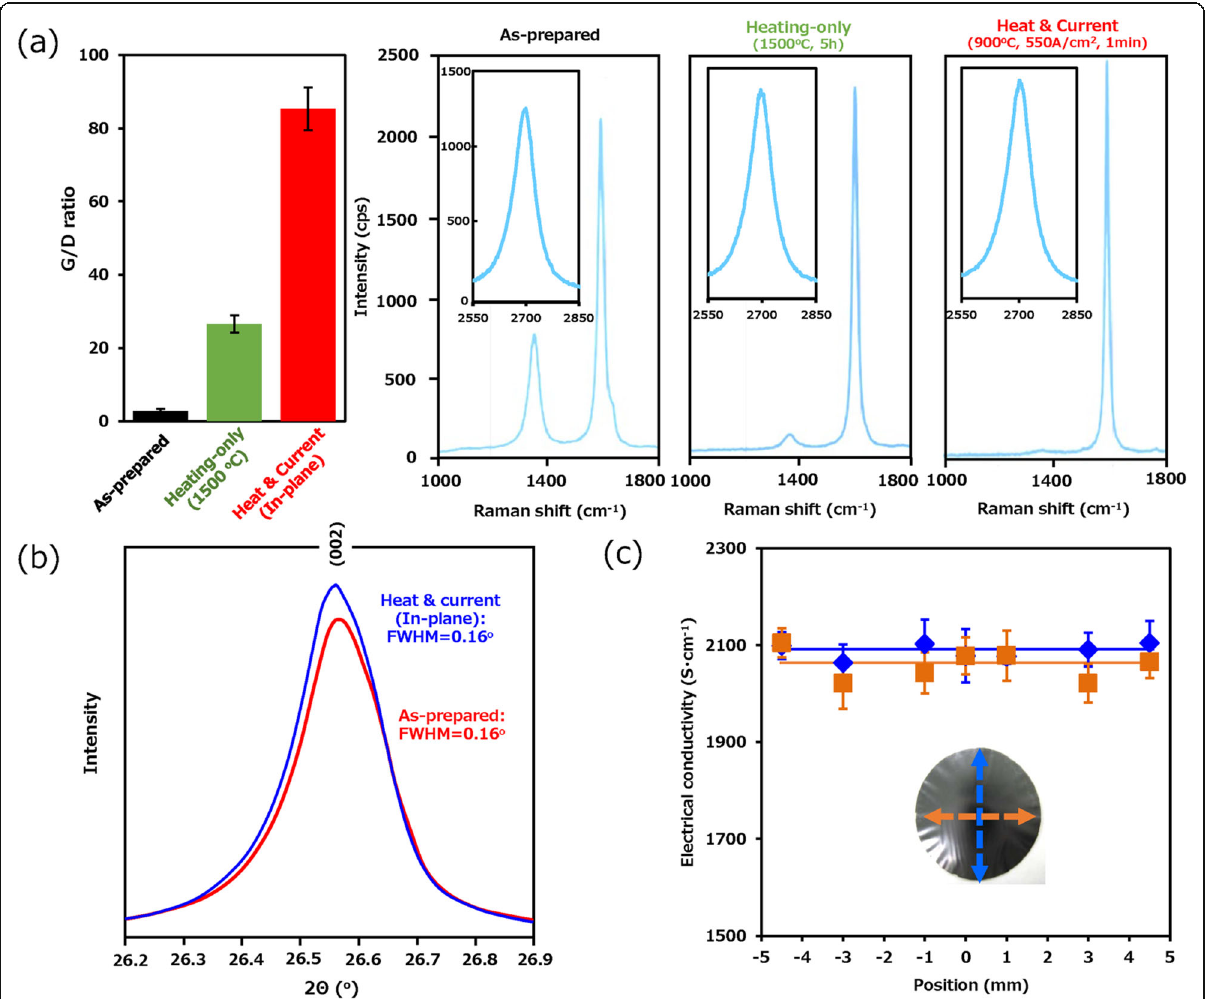
Fig. 3 a Raman spectra of the filtrated, exfoliated graphite sheets before and after heat and current process and after the heating-only process. b FWHM of XRD (002) reflection of as-prepared and processed exfoliated graphite sheet. c Uniformity of the electrical conductivity across the processed exfoliated graphite sheet